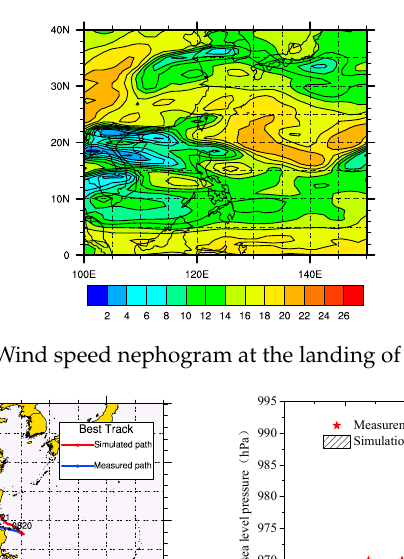
Table 2. Blade parameters of the wind turbine.